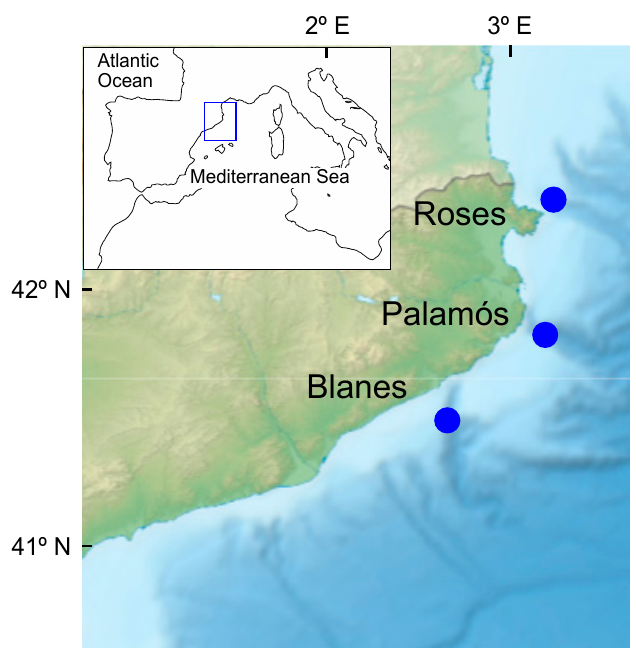
Figure 1. Sampling locations of A. antennatus . Relief map: Sémhur/Wikimedia Commons